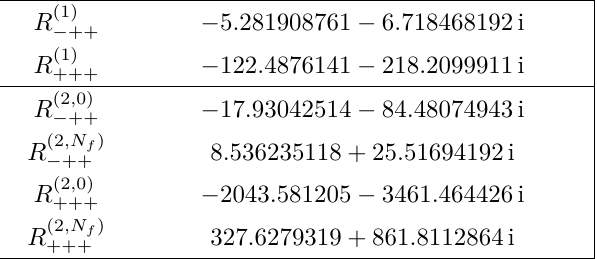
Table 6. Reference evaluations of all independent one-loop and two-loop remainders on the phase- space point of eq.